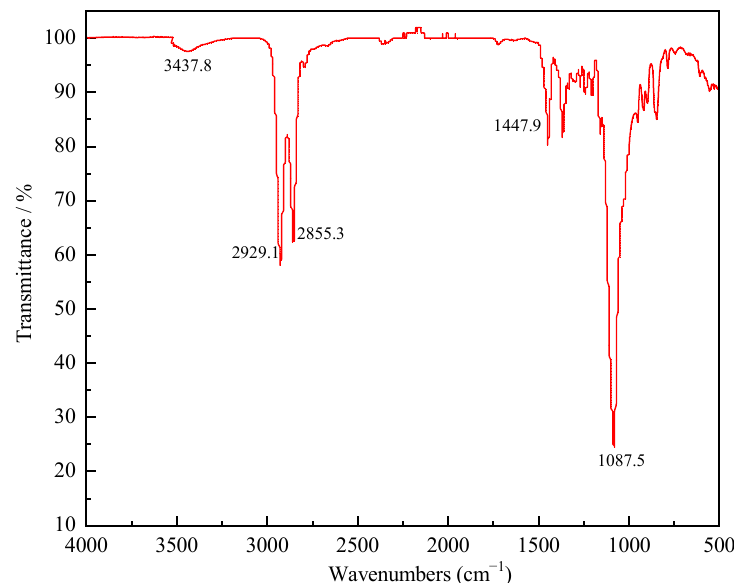
Figure 3. IR spectroscopy of the synthetic copolyether.